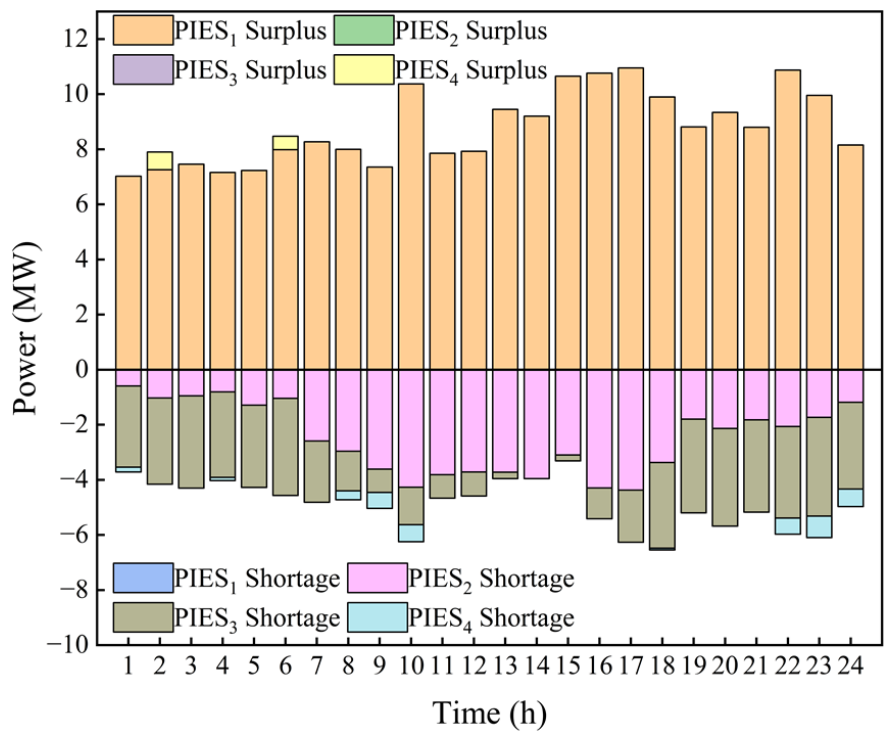
Figure 7. Power surplus and shortage of each PIES.